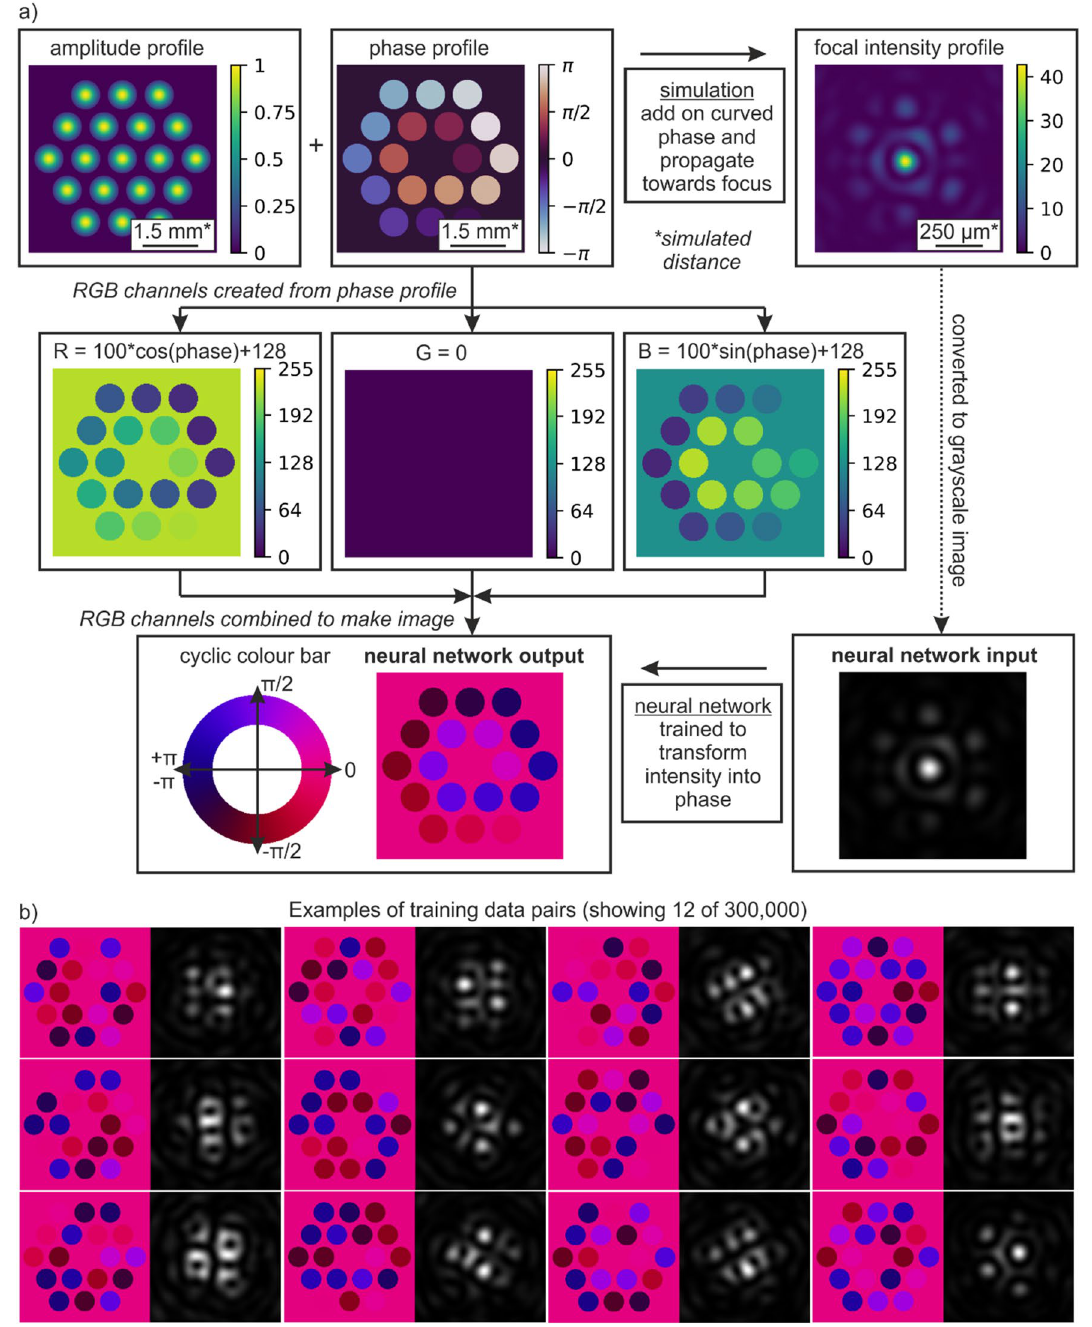
Figure 1. Process for creation of training data suitable for training a neural network to transform a focal intensity profile into the associated phase profile that shows the phase of each fibre. Showing ( a ) schematic of application of beam propagation simulation for creating neural network training data, which produces a 256 × 256 intensity image and associated 256 × 256 phase image. Showing ( b ) twelve examples of training data